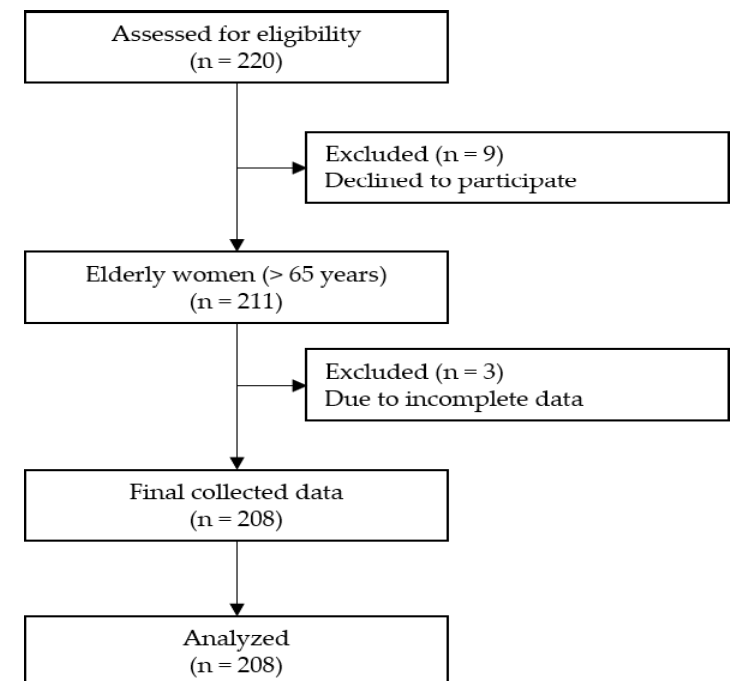
Figure 2. Flowchart of the study.